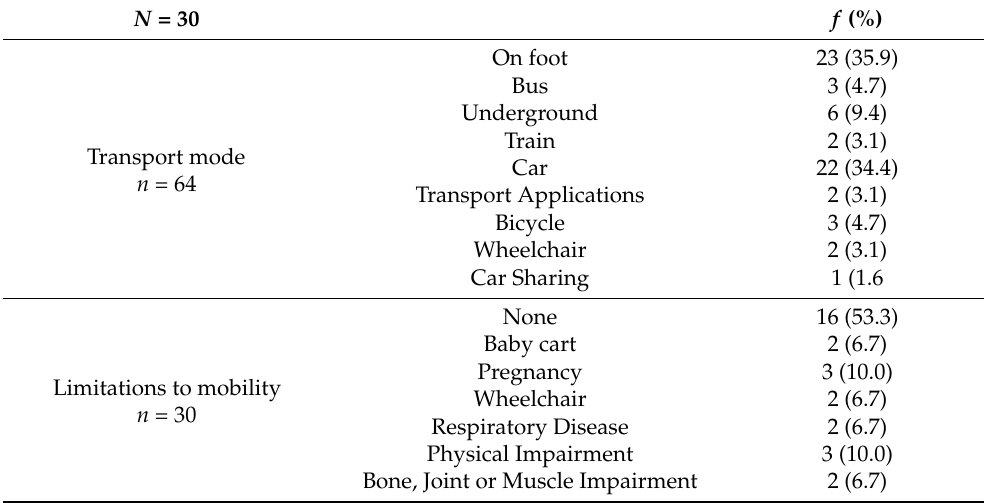
Table 5. Transport mode preference and limitations to the mobility of the focus groups and individual interviews